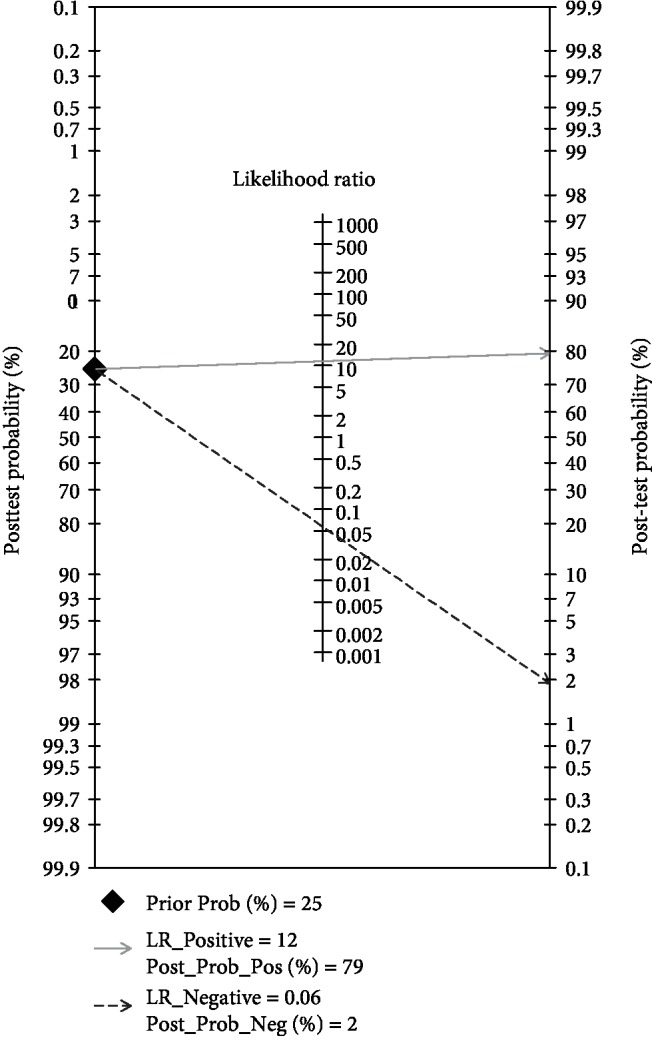
Fagan's nomogram in assessment of the test probabilities after HSF assay.